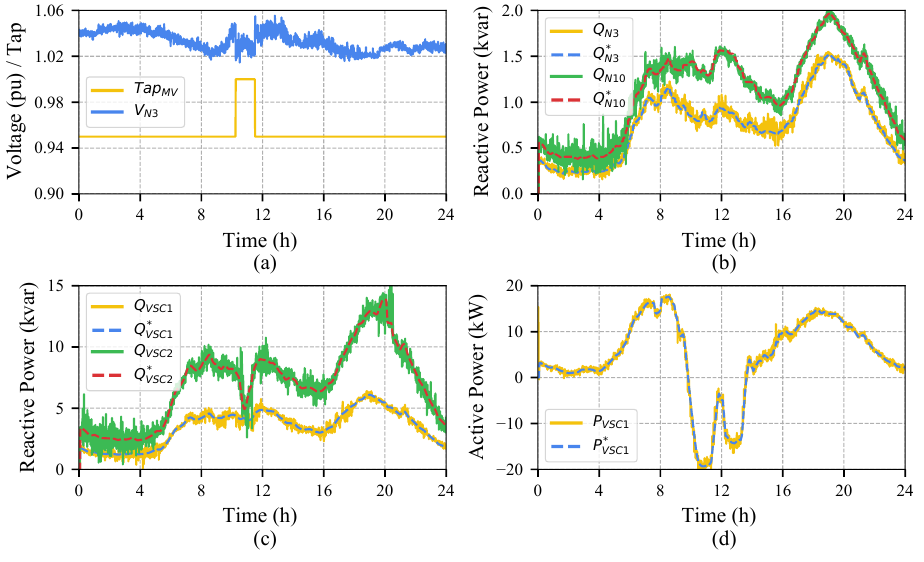
Figure 12. PSHIL-2. DUT performance using 24-h evolution of: ( a ) OLTC tap position and voltage of bus N3. ( b ) DER reactive power injections in buses N3 and N6. ( c ) DC-link reactive power injections. ( d ) DC-link active power transfer from N8 to